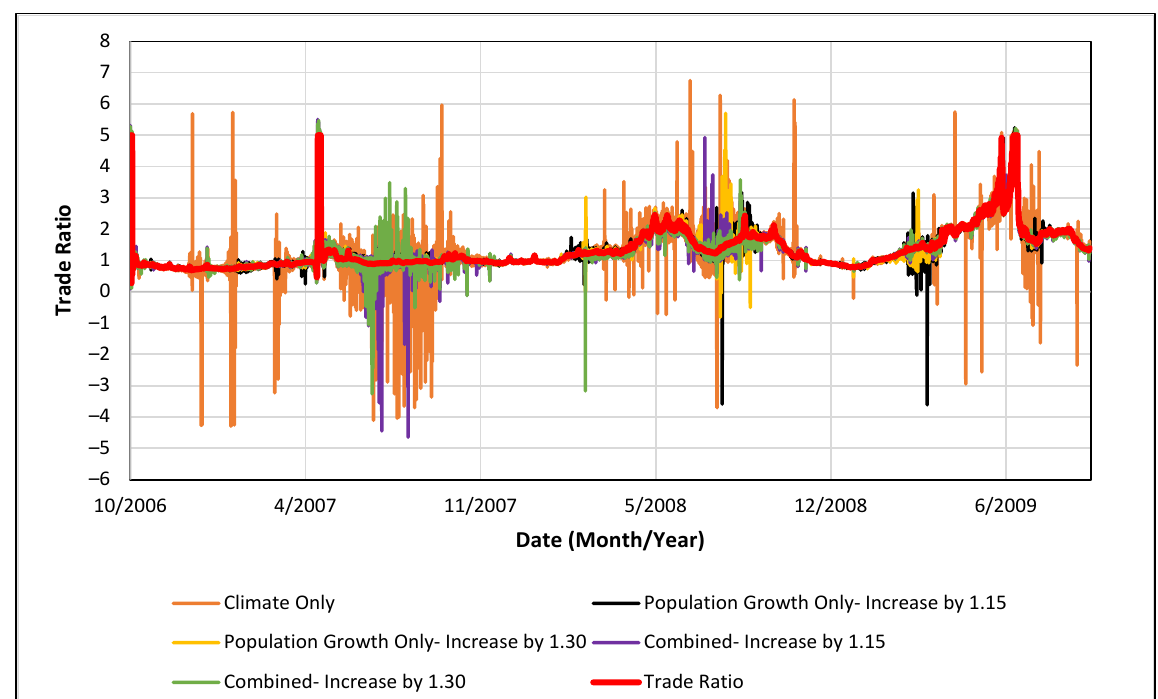
Figure 13. Composite Trade Ratio based on Sums for Delivery + Downstream Components with Equivalency Adjustments for Theoretical WQT Buyer BOD Combined with Suggested Margins of Safety for Climate and Population Characteristics over the Jordan River Simulation Period (1 October 2006 to 30 September 2009) for RCP 6.0.